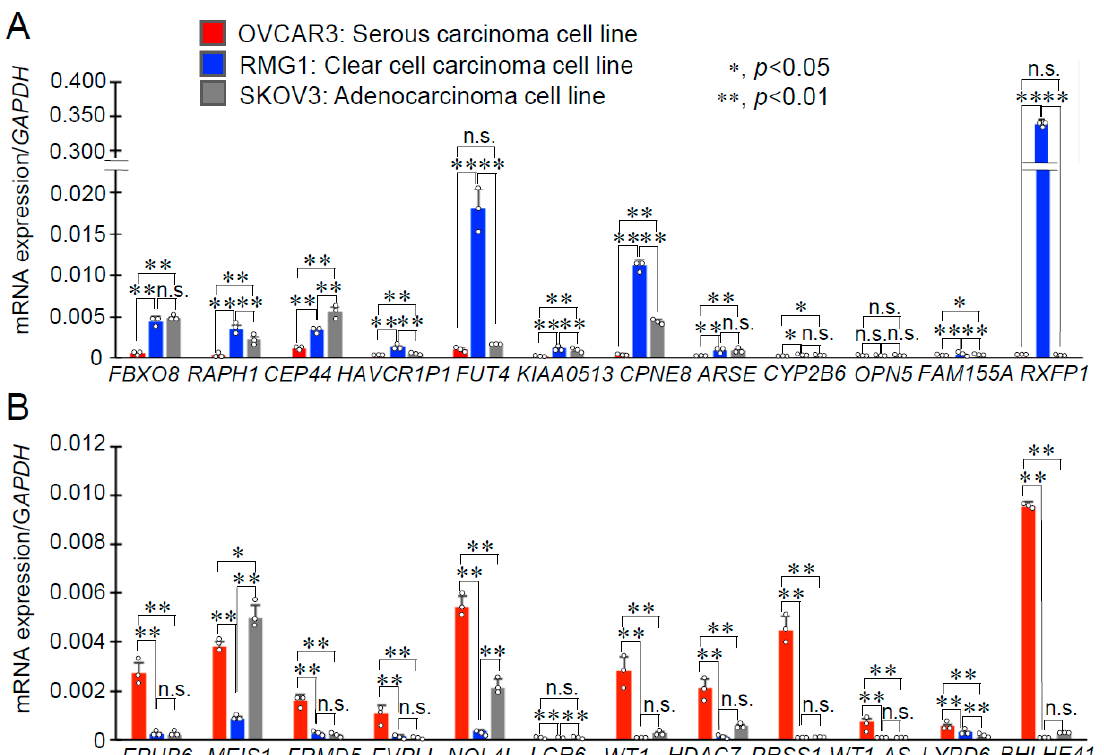
Figure 3. mRNA expression of CPNE8 and BHLHE41 in ovarian cancer cell lines. ( A ) The expression levels of the top 12 genes that separated CCC from HGSC (PC1 negativity in Figure 1E) were examined in HGSC-derived OVCAR3, CCC-derived RMG1, and adenocarcinoma-derived SKOV3 cells by qRT-PCR. ( B ) The expression levels of the top 12 genes that separated HGSC from CCC (PC1 positivity in Figure 1E) were examined in OVCAR3, RMG1, and SKOV3 cells by qRT-PCR. Relative mRNA levels are expressed as means ± SD ( n = 3), by normalizing to GAPDH level. Row data are plotted with circles; *, p < 0.05; **, p < 0.01, using one-way ANOVA with Tukey’s HSD test; n.s., not significant.